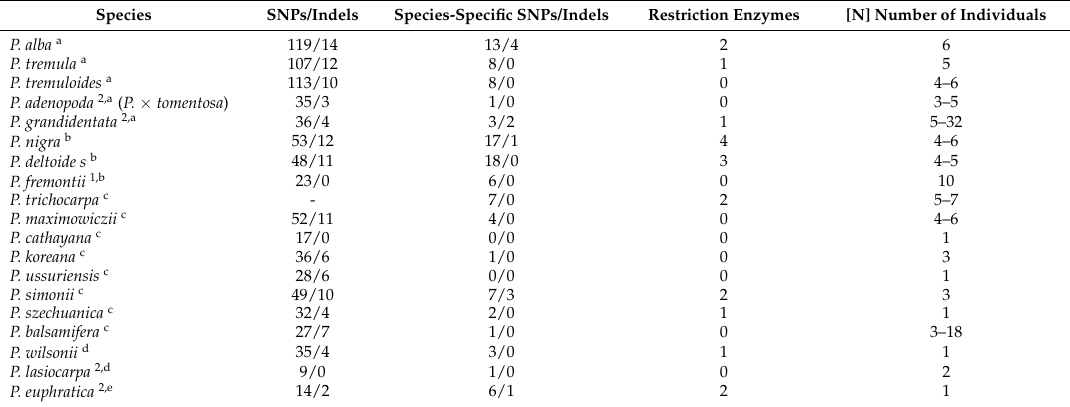
Table 3. Number of SNPs and indels in the nuclear regions analyzed in this study. Overview of the total number of found SNPs and indels, species-specific SNPs and indels, and related restrictions enzymes for the species-specific SNPs for use in PCR-RFLPs in the four nuclear regions. All of the SNPs/indels counted were nucleotide variations that were different from P. trichocarpa . The number of individuals per species used for marker validation is also given.